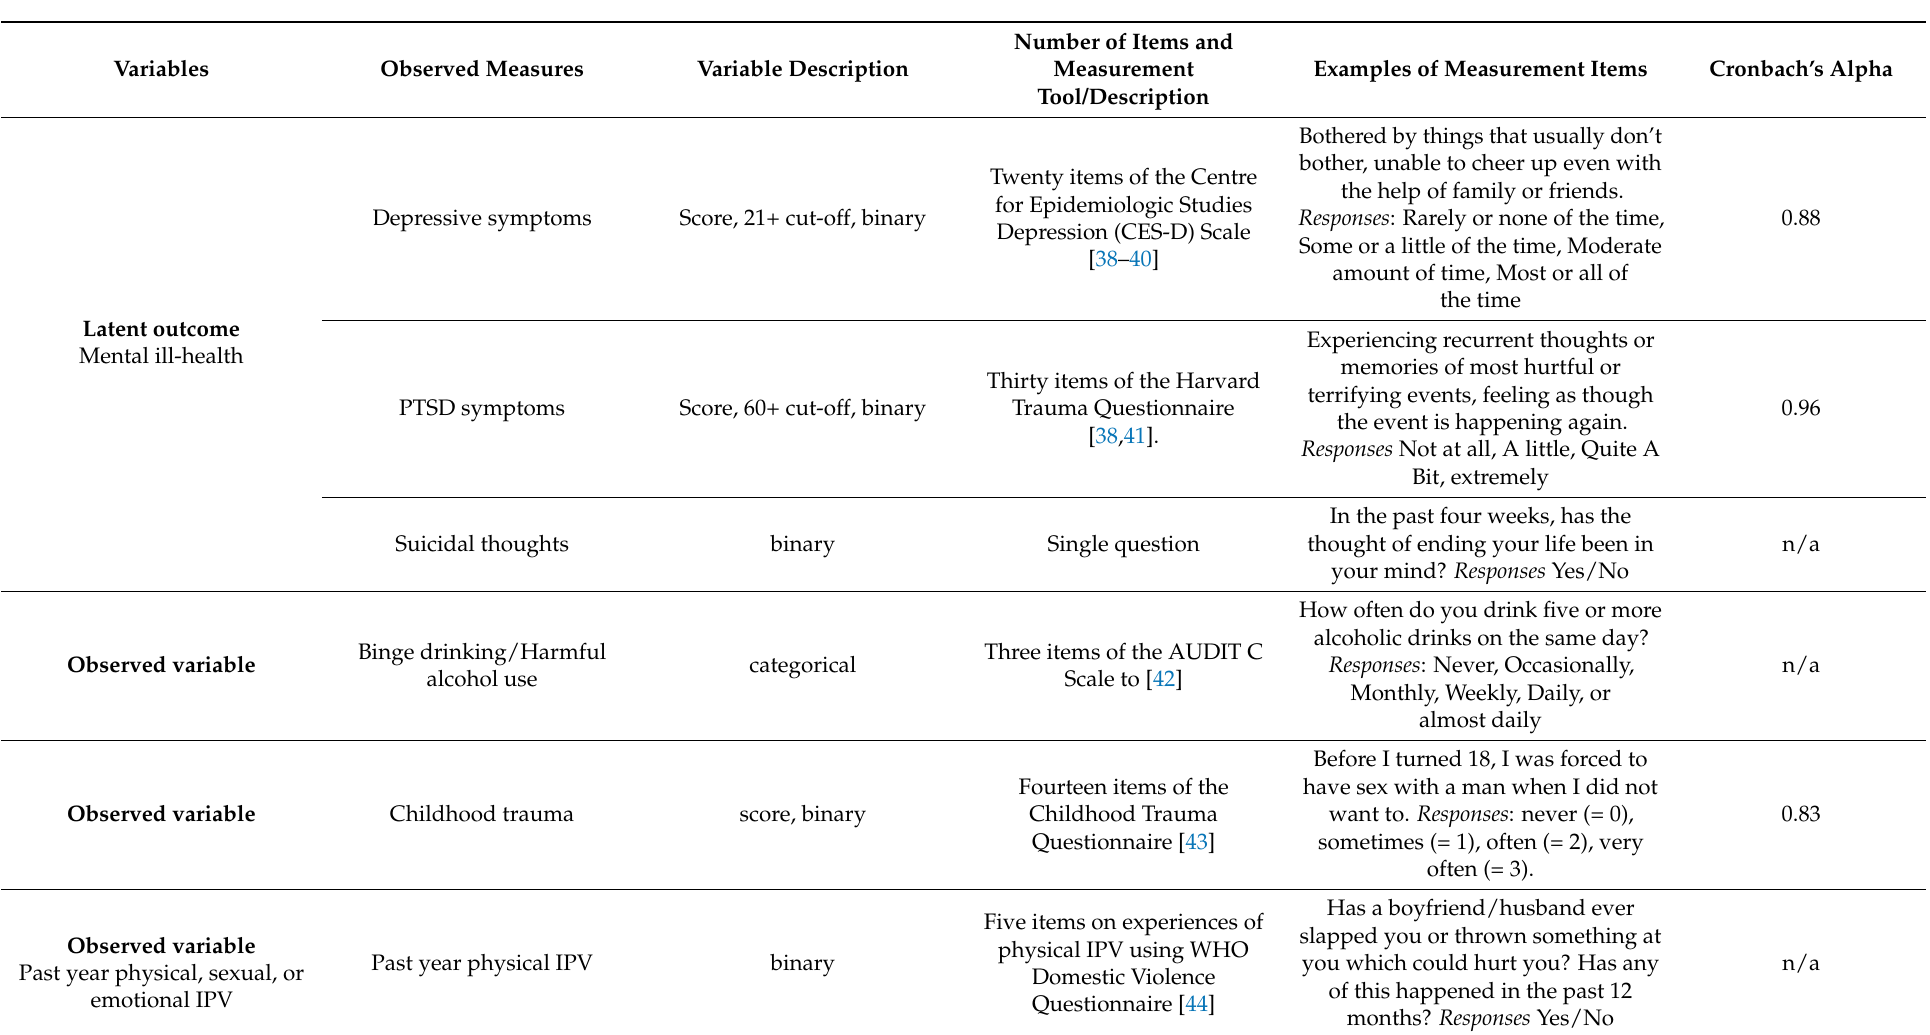
Table 1. Variable